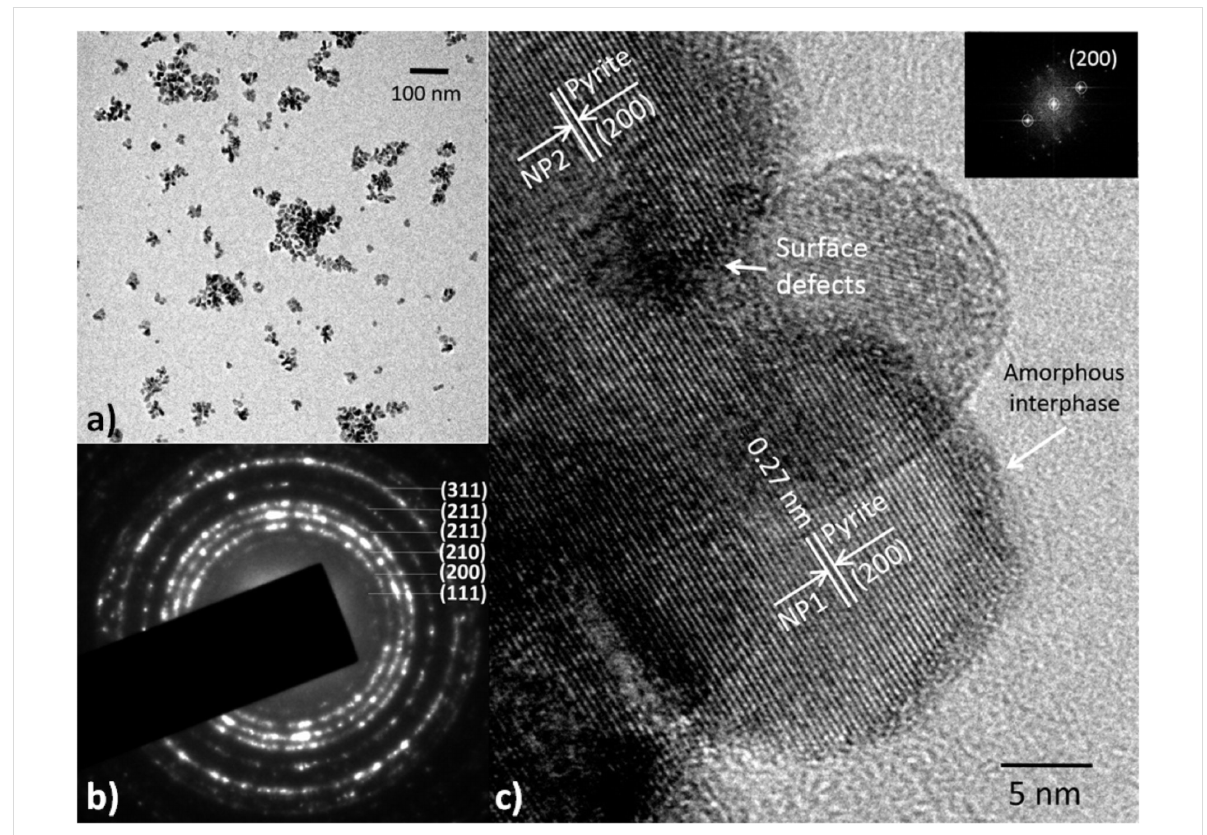
Figure 2: a) TEM image of the typical distribution of the nanoparticles, comprising polycrystalline aggregates of pyrite. b) SAED pattern of the nanoparticles. c) HR-TEM image showing the structure of the nanoparticles. Individual nanoparticles tended to self-assemble, thereby forming finite- size crystalline domains extended over several particles. The surface of the nanoparticles always appeared to be surrounded by an amorphous